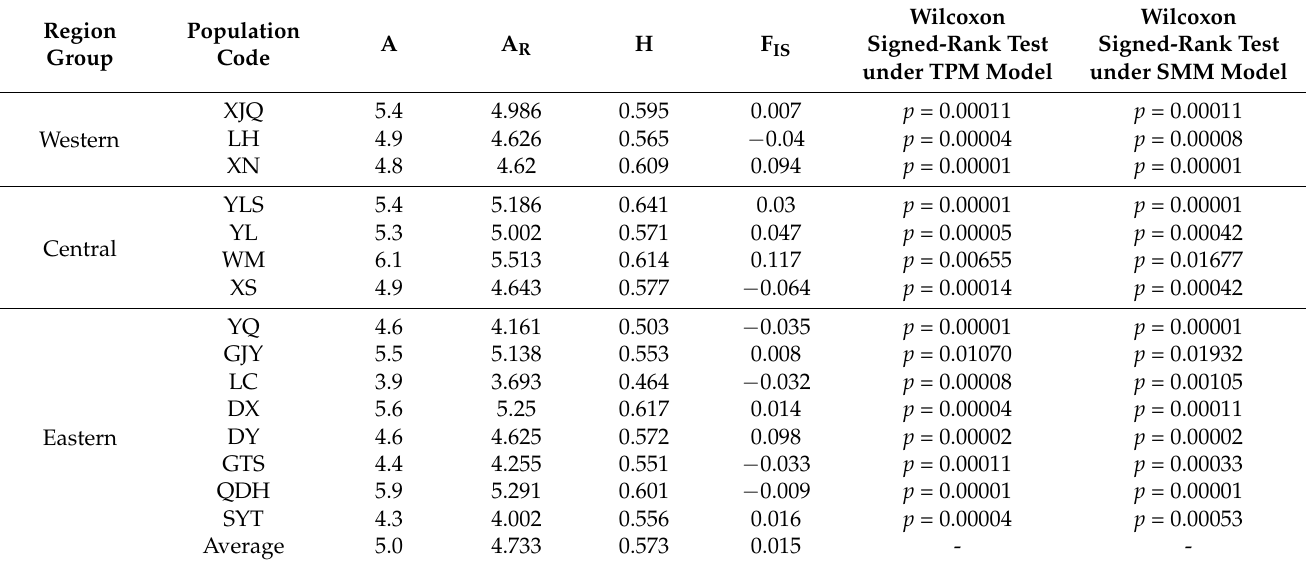
Table 4. Genetic diversity parameter in 15 populations of Castanopsis sclerophylla at the 16 SSR